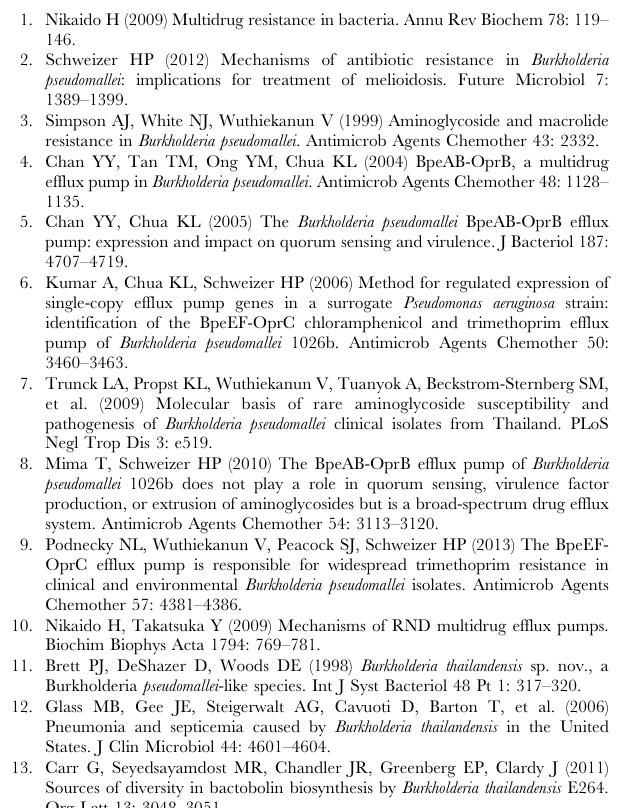
Figure 2. Quantitative RT-PCR analysis of bpeF (Figure 2A), amrB (Figure 2B) and bpeB (Figure 2C) gene expression. Expression levels were normalized with respect to the four reference genes previously selected, with wild-type strain E264 levels set to 1. Values are presented as means 6 SEM of four biological replicates and are compared with the value for the wild-type strain E264. Significant differences are indicated by a single asterisk indicating a p -value , 0.05 (Mann-Whitney U tests). Error bars indicate one standard error of the